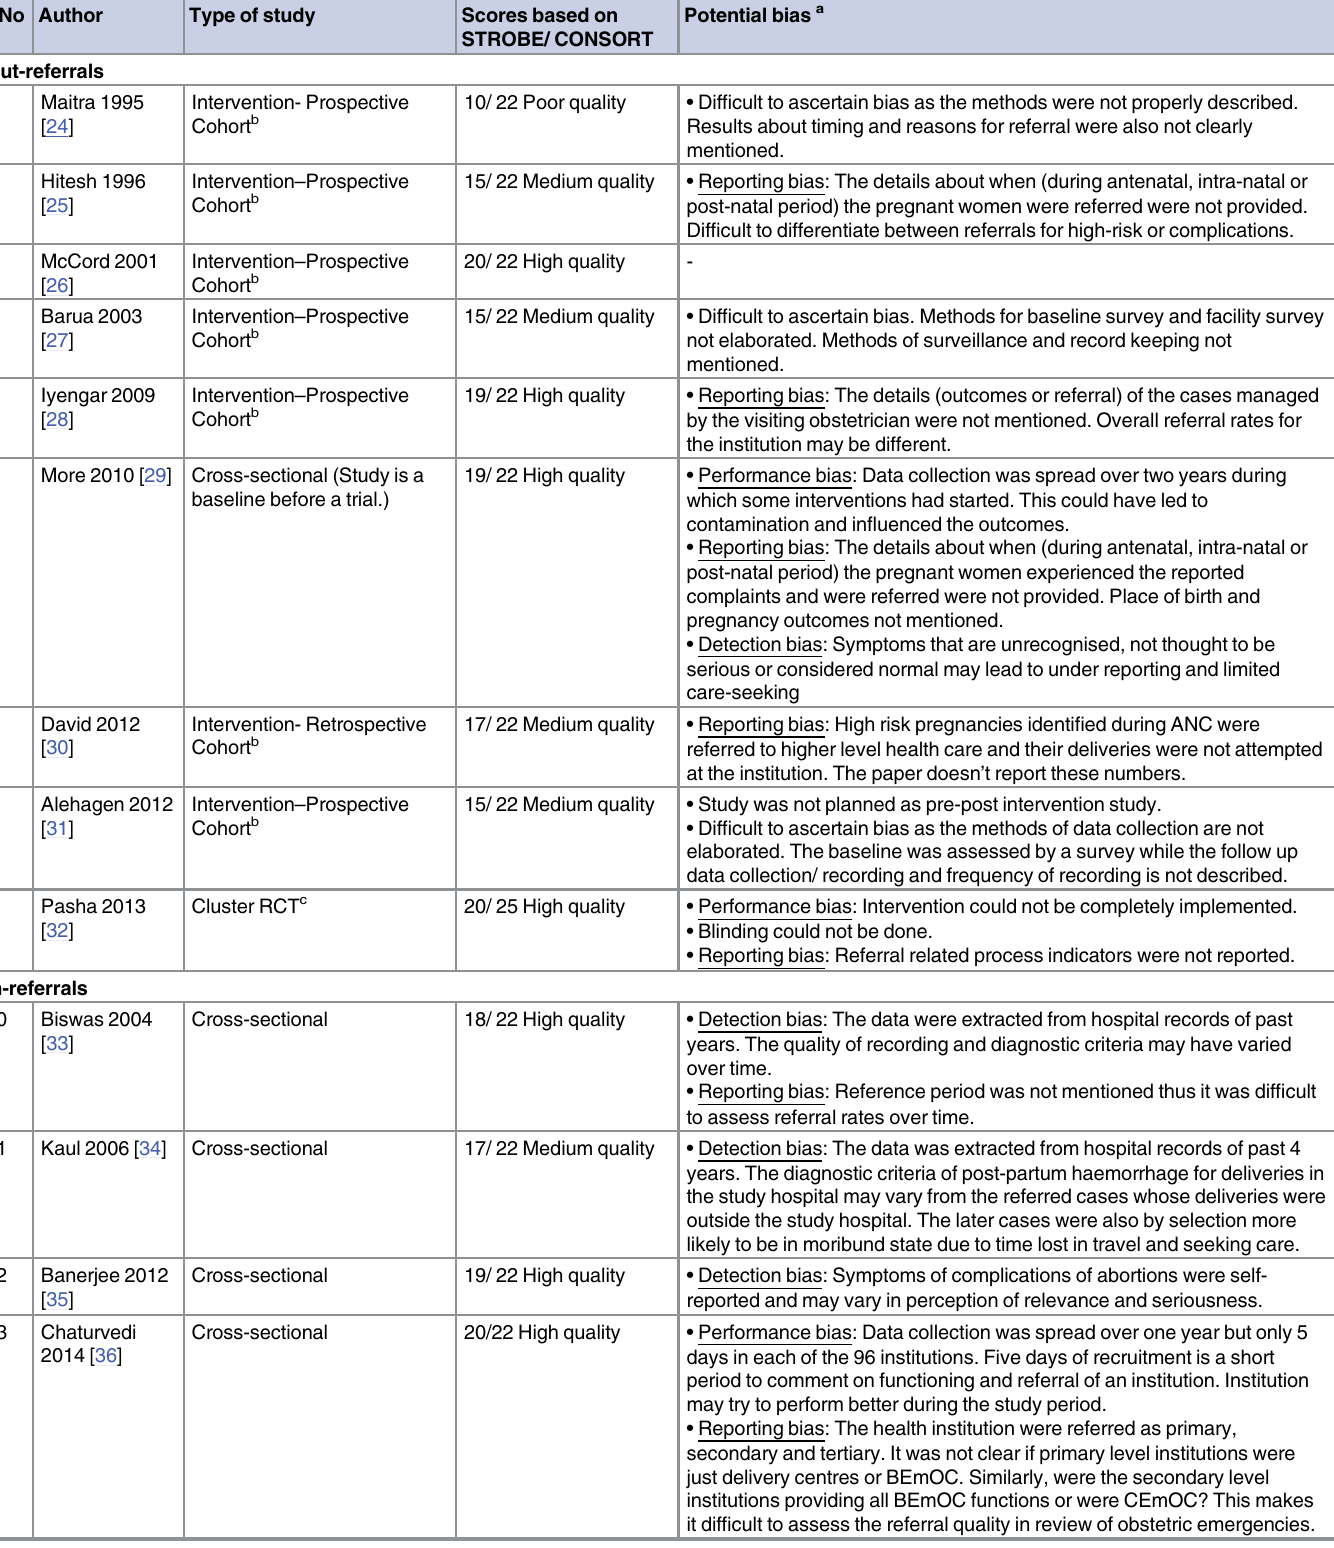
Table 2. Quality scores (based on Strobe and Cochrane guidelines) and potential